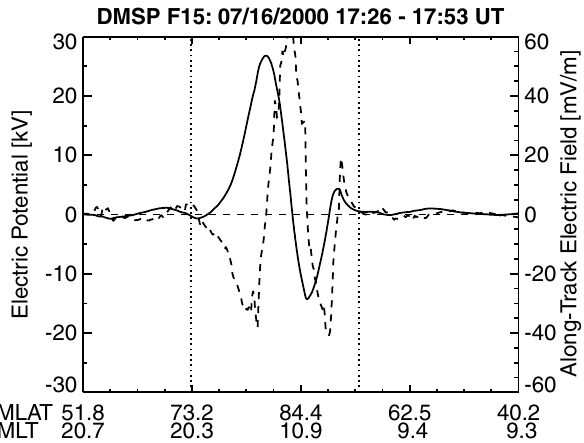
Fig. 12. Electric potential (solid line) derived from the along-track electric field component (dashed line) for the DMSP F15 pass. The vertical dashed lines mark the transition between Region-1 and Region-2 sense Birkeland currents.